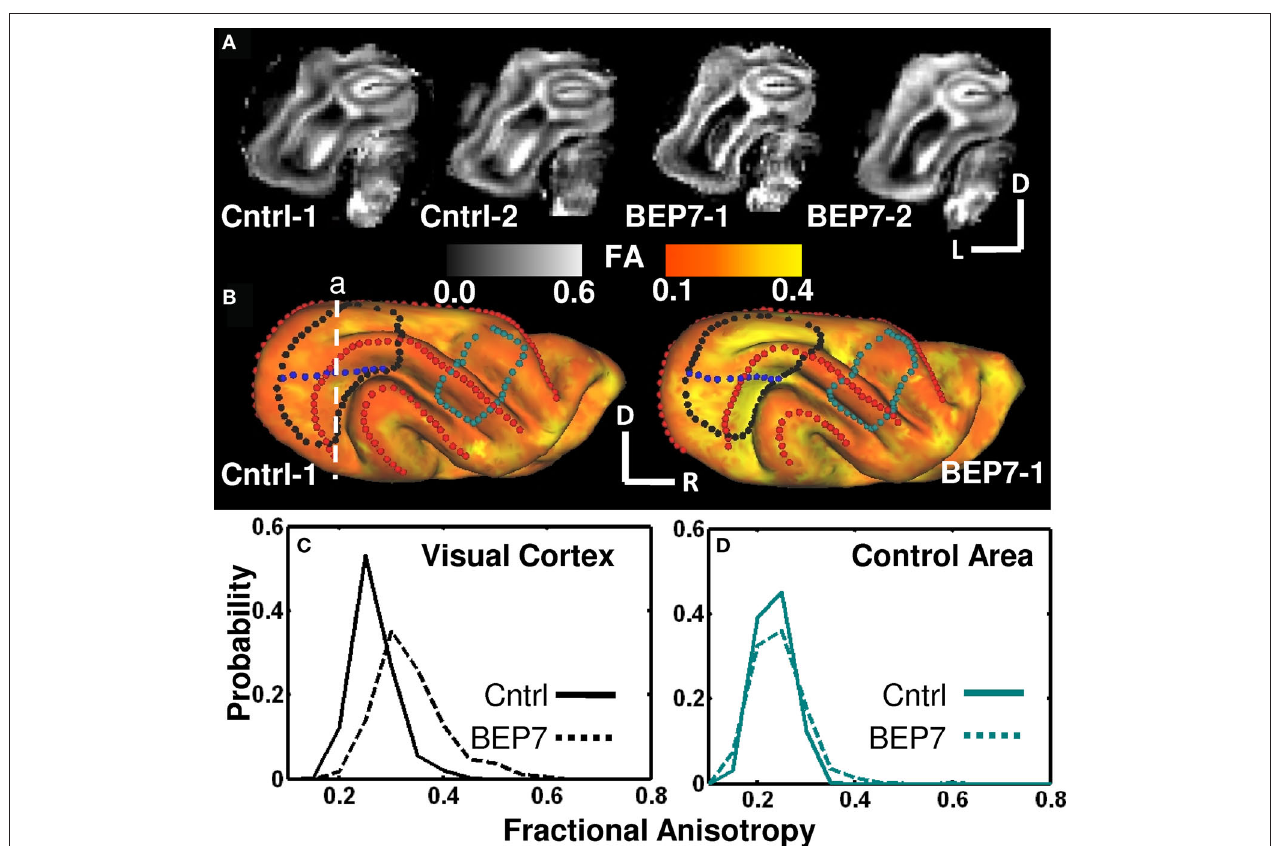
FiGure 3 | Post mortem DTi measurements of two BeP7 hemispheres show increased visual cortical FA relative to two control hemispheres at P31. Coronal views of FA parameter maps are shown in (A) for two control animals (left) and two BEP7 animals (right) according to the gray color scale. In (B) , cortical FA is presented on cortical surface models for animals Cntrl-1 and BEP7-1, according to the red/yellow color scale. In A and B , increased FA is